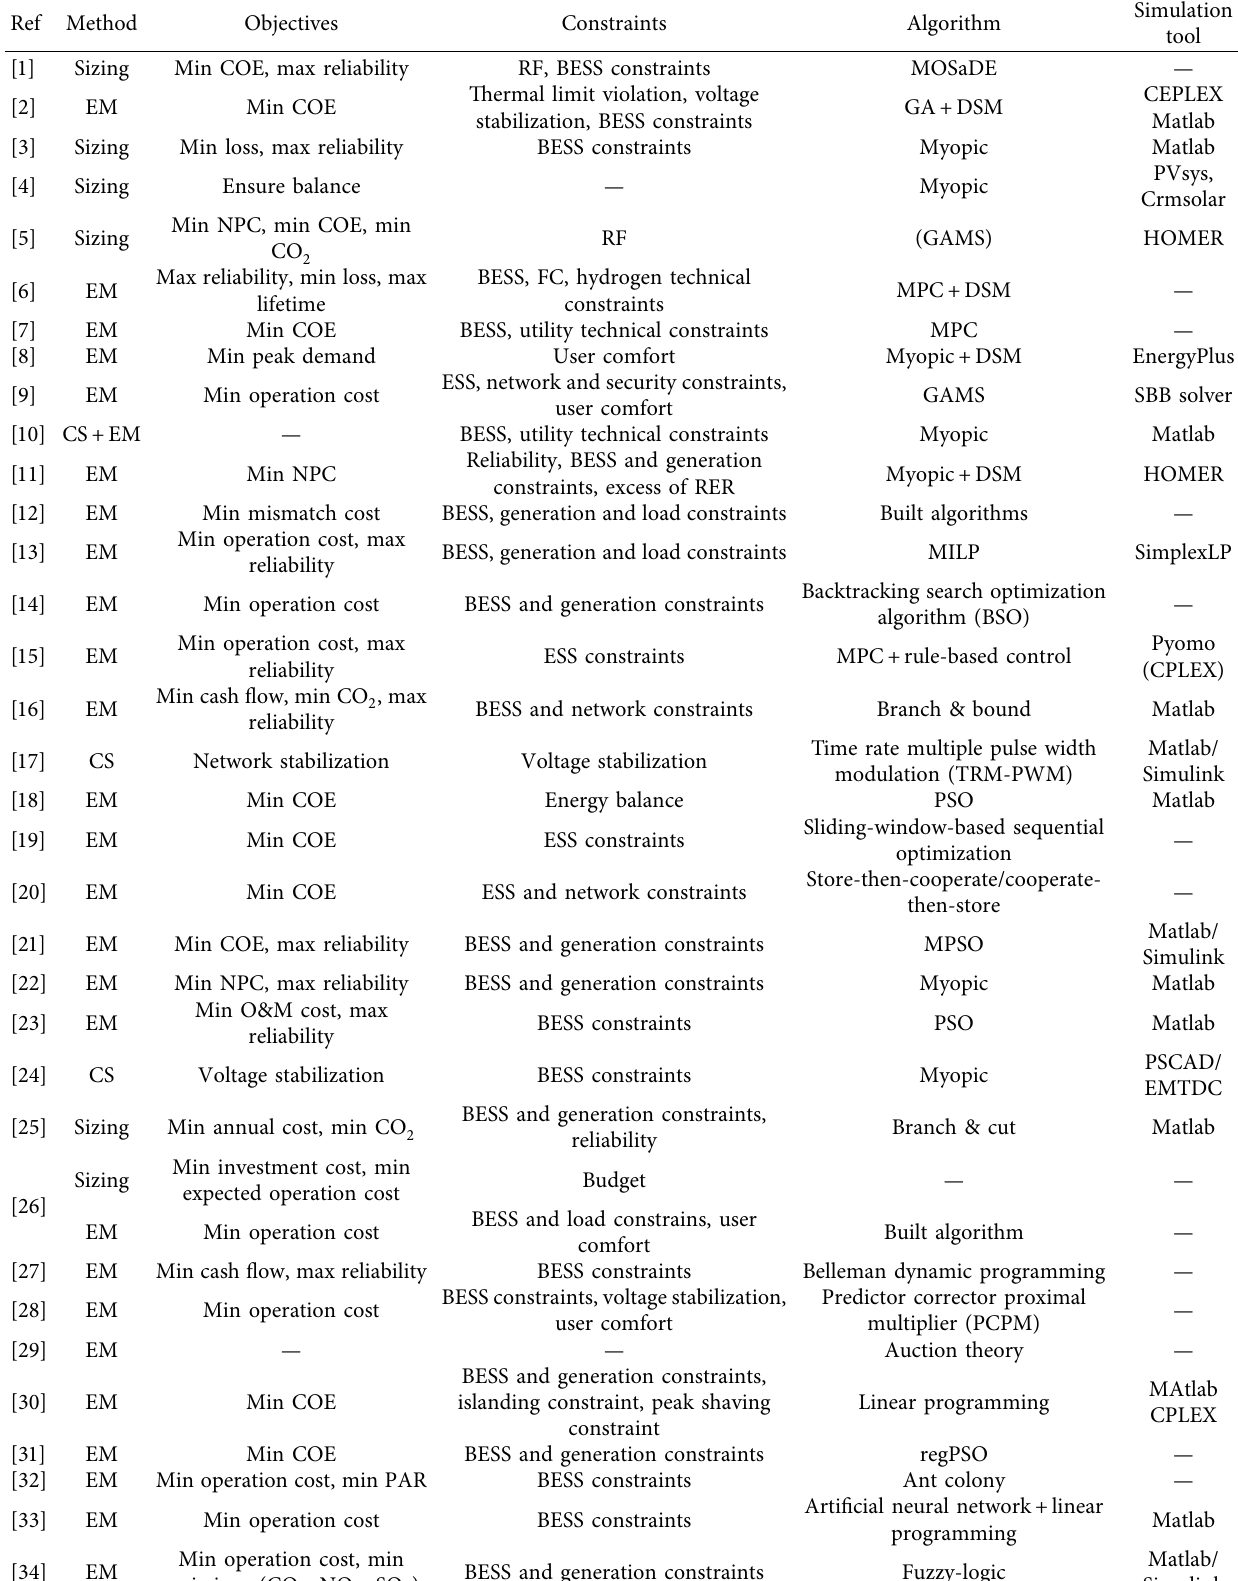
Table 5: Energy management